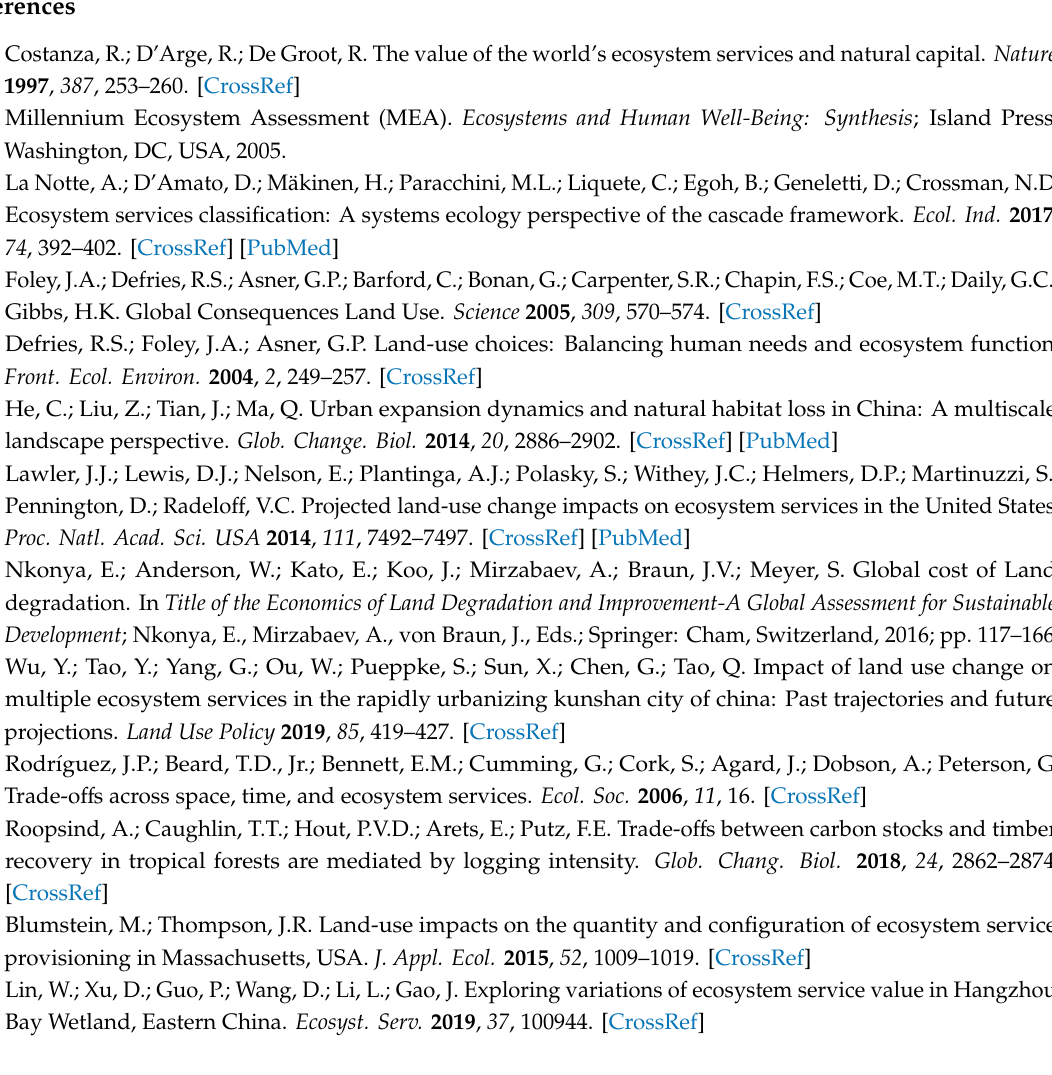
Figure S1: Land-use maps of 2000 for the ecological conservation area in Beijing, China. Table S1: Description of land-use types. Table S2: Driving factors of land-use change. Table S3: Conversion cost matrix from 2000 to 2015 (km 2 ). Table S4: Input data on carbon stored in each of the four fundamental pools for each LULC class in the InVEST 3.8.0 model (Mg / ha). Table S5: Input data for each LULC class in the InVEST 3.8.0 water yield model. Table S6: Input data for each LULC class in the InVEST 3.8.0 sediment delivery ratio model. Table S7: Carbon storage (CS) for each land-use type from baseline, in 2030 under the BAU, ELP, and RED scenarios (Tg). Table S8: Water yield (WY) for each land-use type from baseline, in 2030, under the BAU, ELP, and RED scenarios (million m 3 ). Table S9: Soil conservation (CS) for each land-use type from baseline, in 2030, under the BAU, ELP, and RED scenarios (million ton). Table S10: Correlation among three ecosystem services for each scenario. Table S11, Ecosystem service (ES) change matrix driven by per-unit land-use transitions of the main land-use types, from 2015 to 2030, under the BAU, ELP, and RED